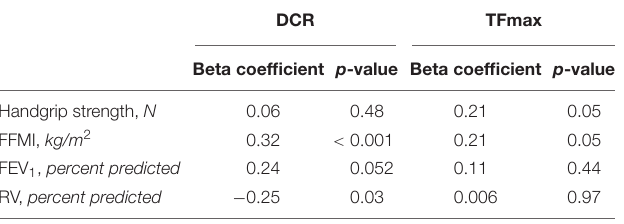
TABLE 4 | Multiple linear regression models assessing the independence of the relationship between clinical predictors and ultrasound results. DCR